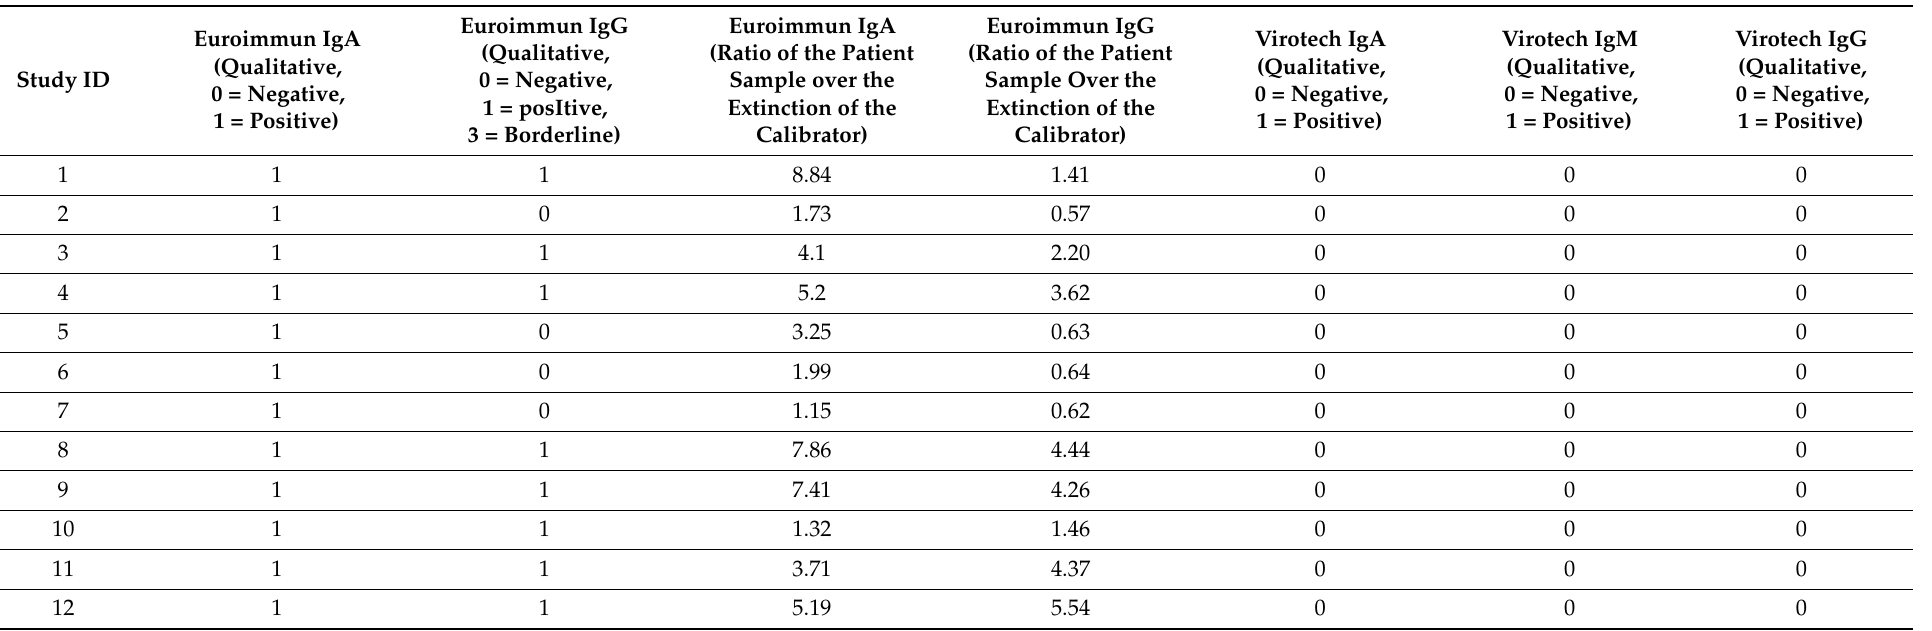
Table A2. Raw data of the serological test results—for the VIROTECH results, only qualitative data are